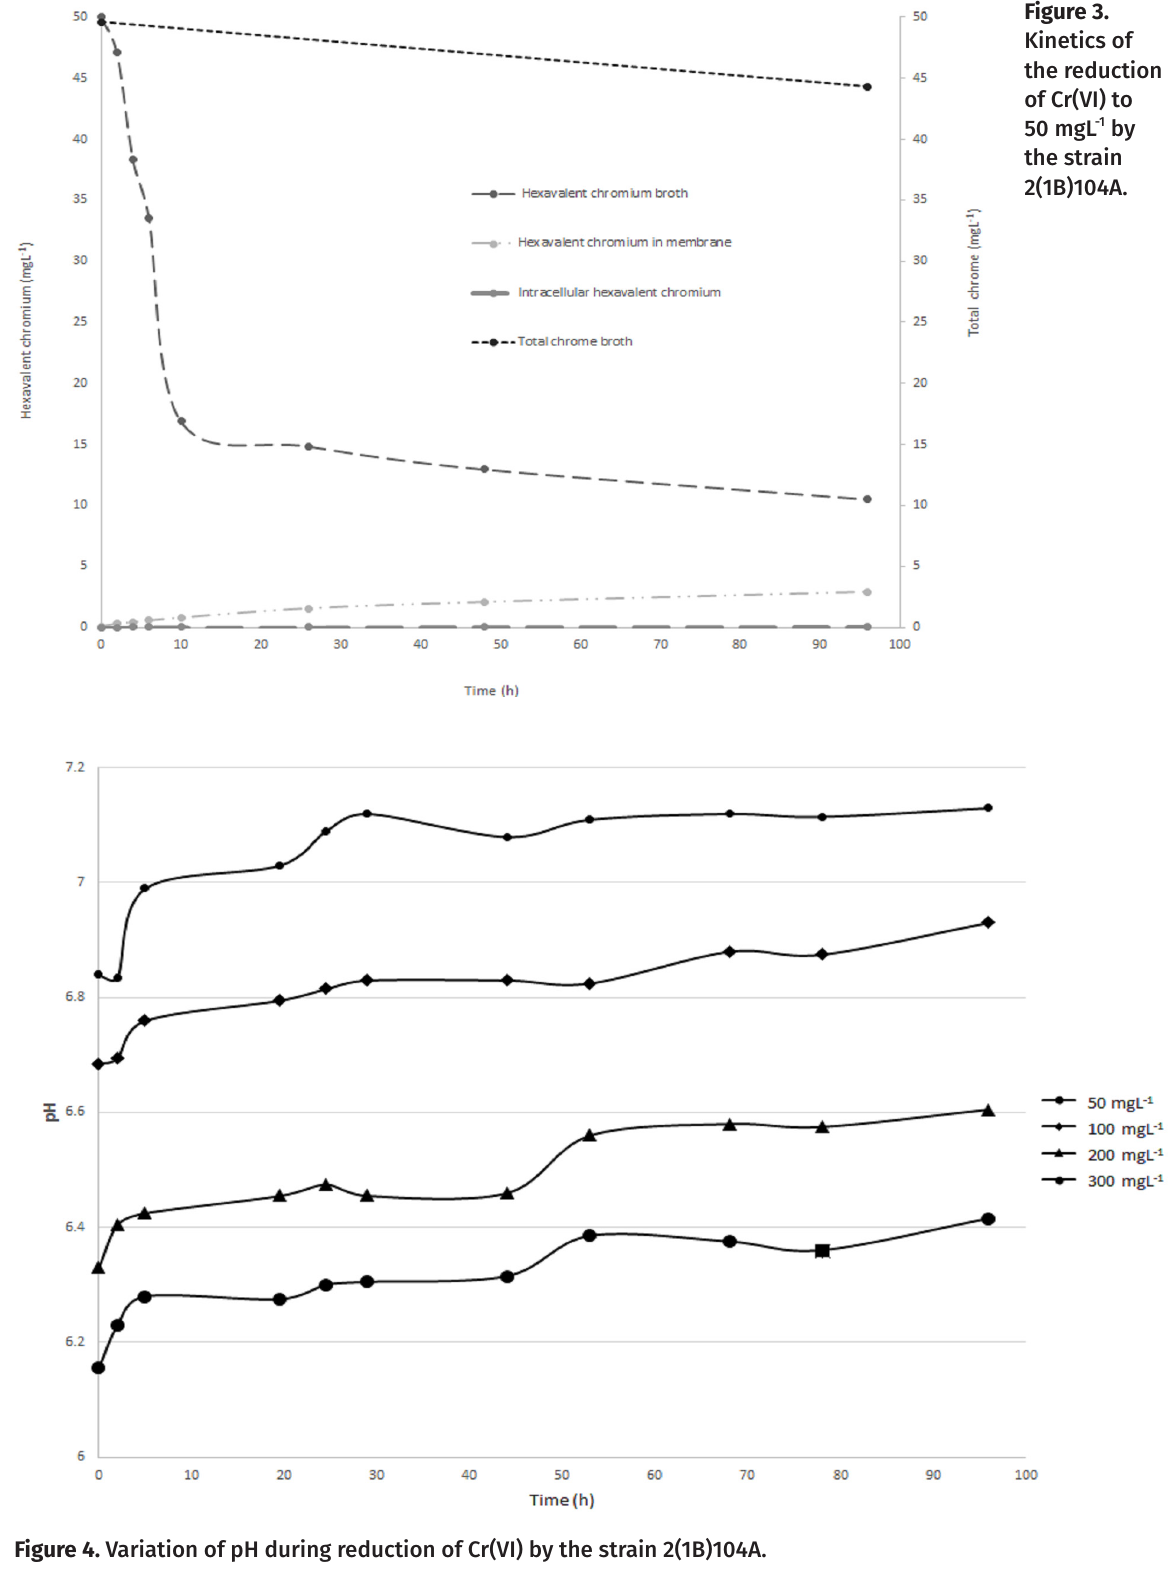
Figure 4. Variation of pH during reduction of Cr(VI) by the strain